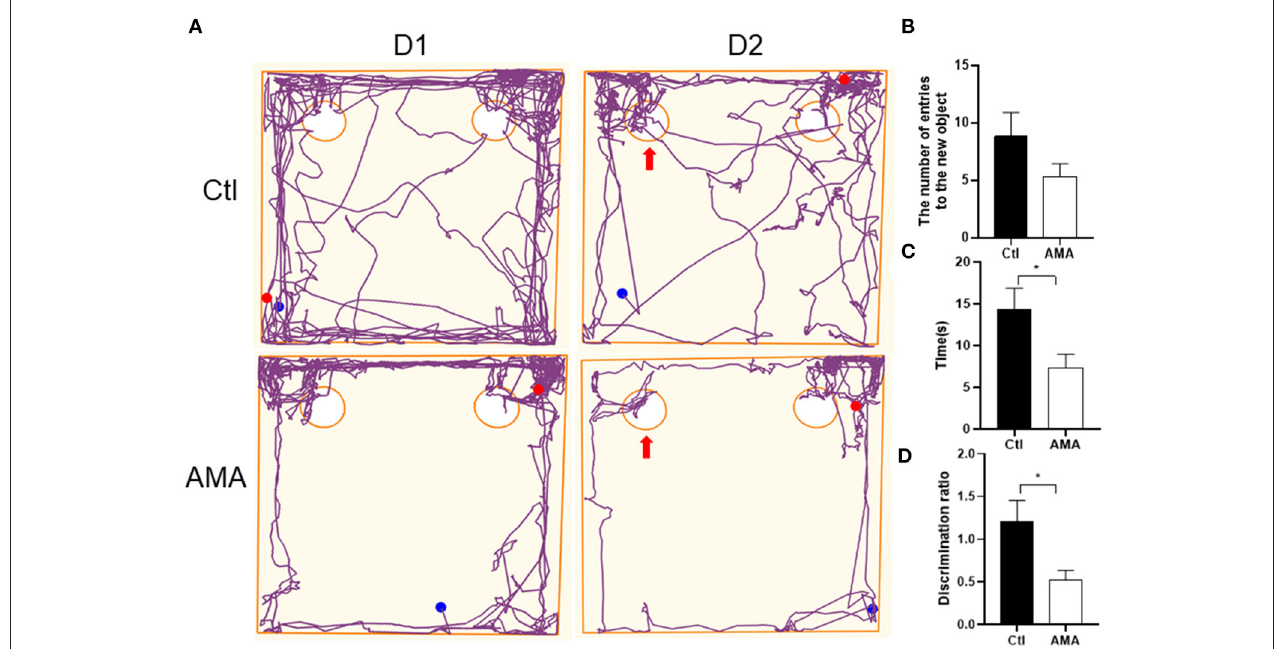
FIGURE 1 | The discrimination ratio of the exploration time affected by AMA in the novel object recognition test. (A) Representative track maps in the novel object recognition test showed that offspring in Ctl spent more time around the novel object (as arrow shown) and reflected a better ability to explore new objects than offspring in the AMA group. (B) The number of the rat touched the novel object with its nose, (C) the time of the rat stood near the novel object, and (D) the discrimination ratio in the Ctl and AMA groups. All data are shown as the mean ± SEM, n = 6 in each group, * P <